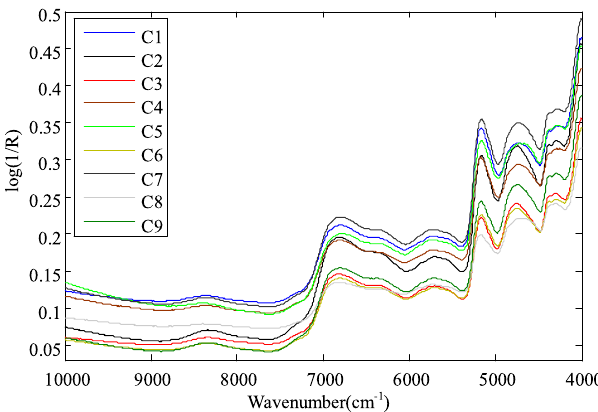
Fig. 1. The mean spectra of each class for the original